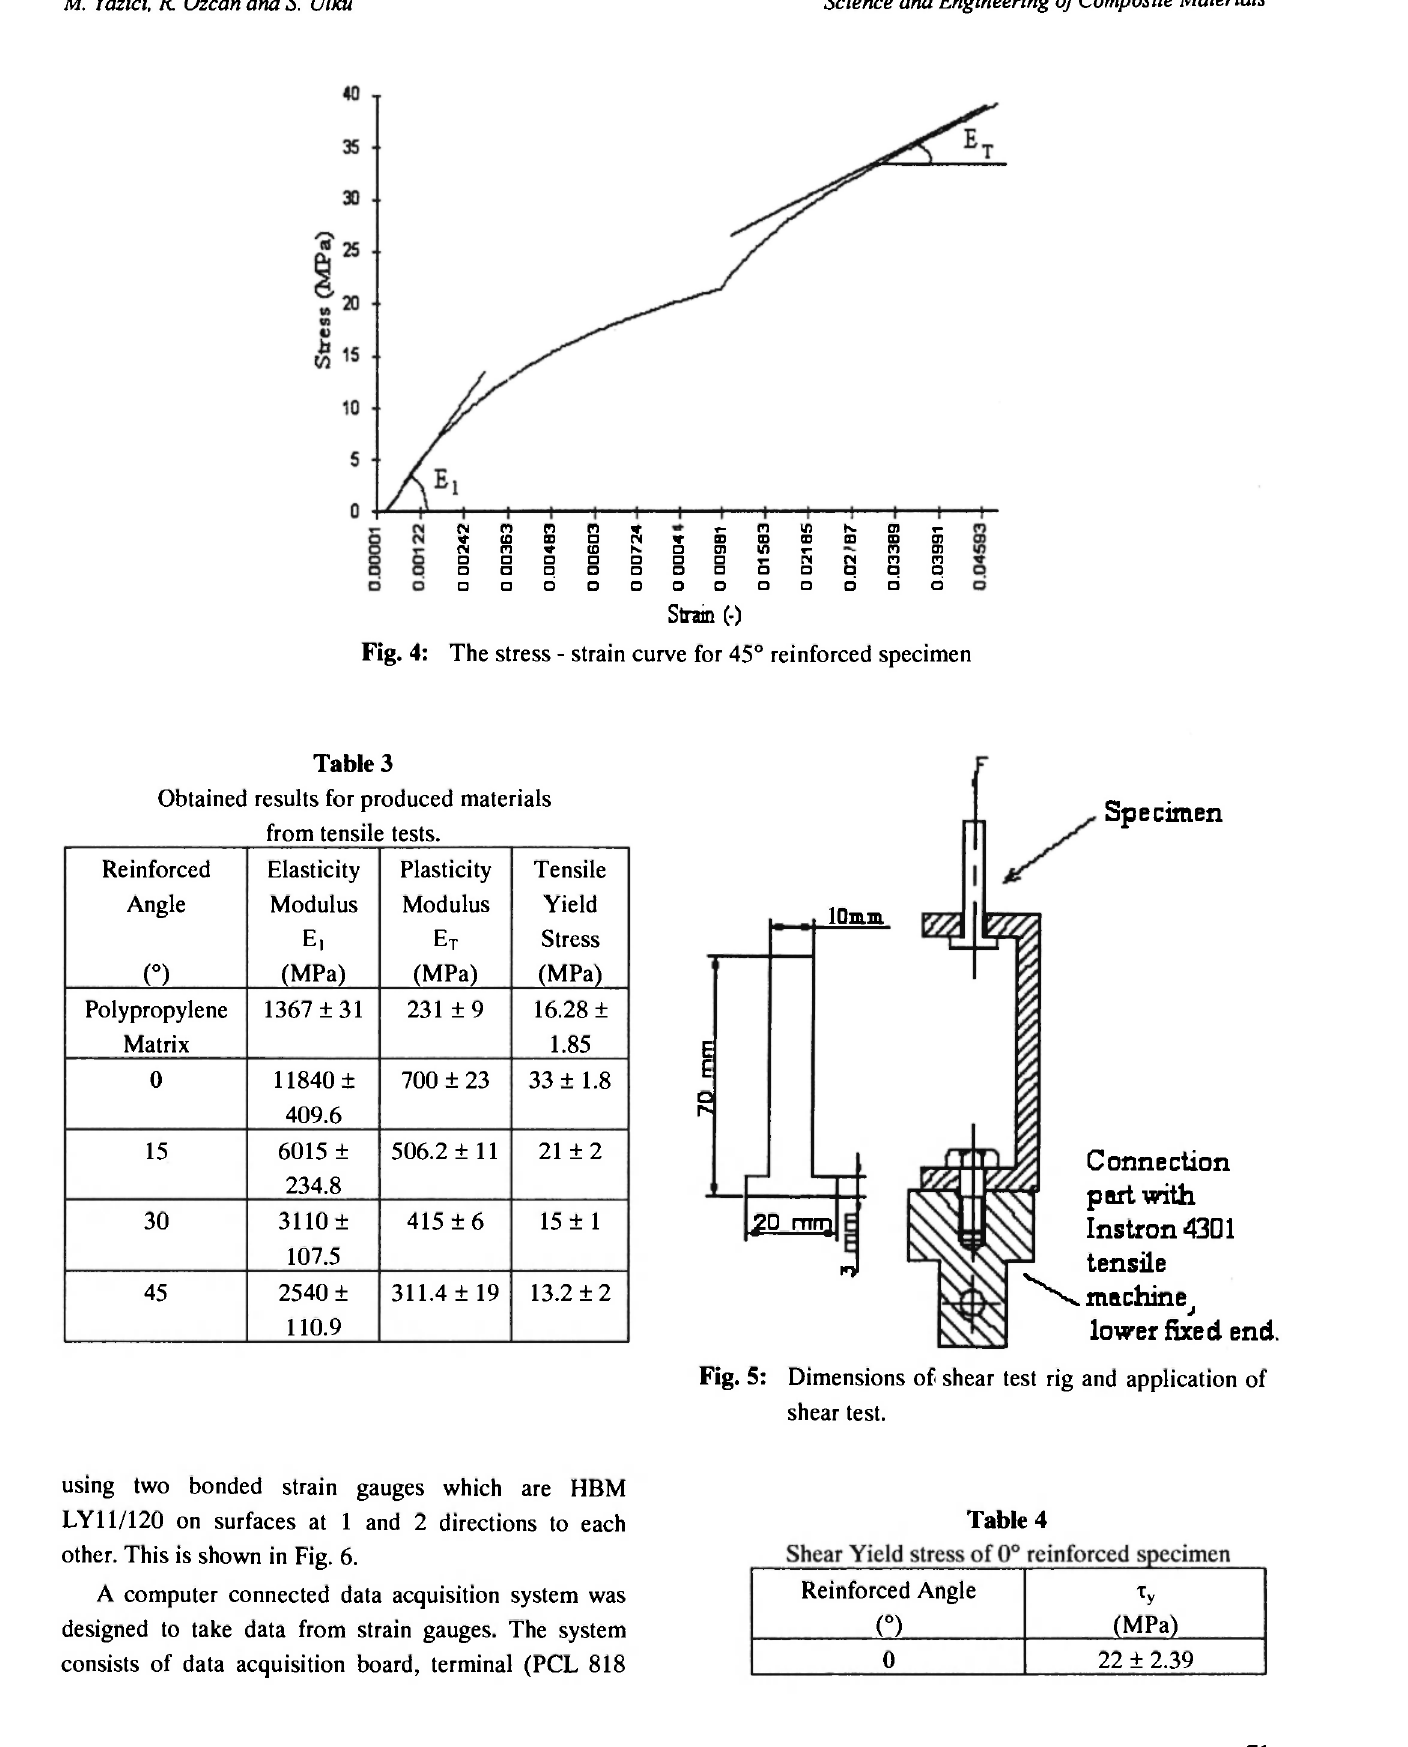
Fig. 5: Dimensions of shear test rig and application of shear